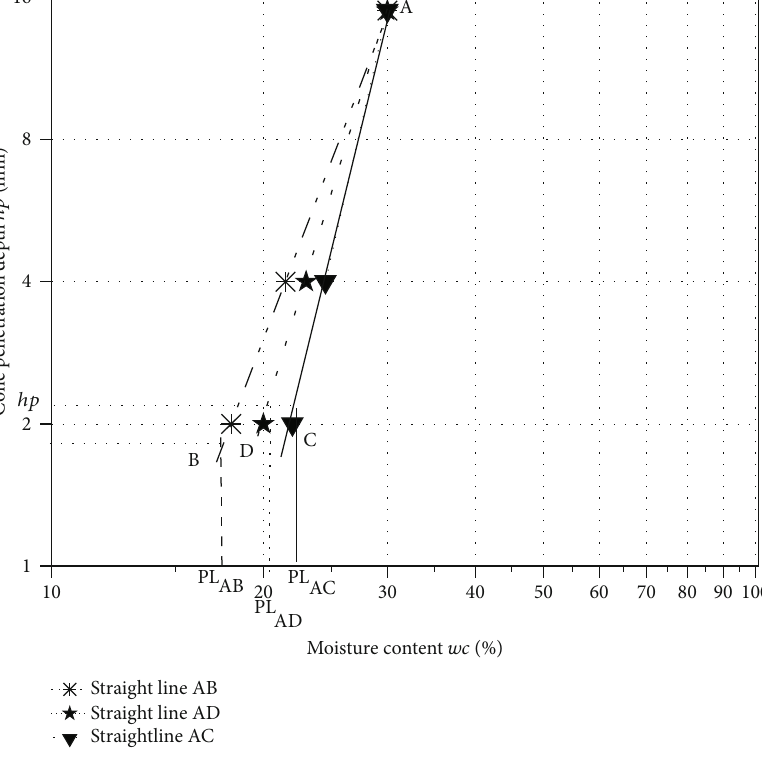
Figure 3: Relationship between the cone penetration depth ( hp ) and moisture content ( wc